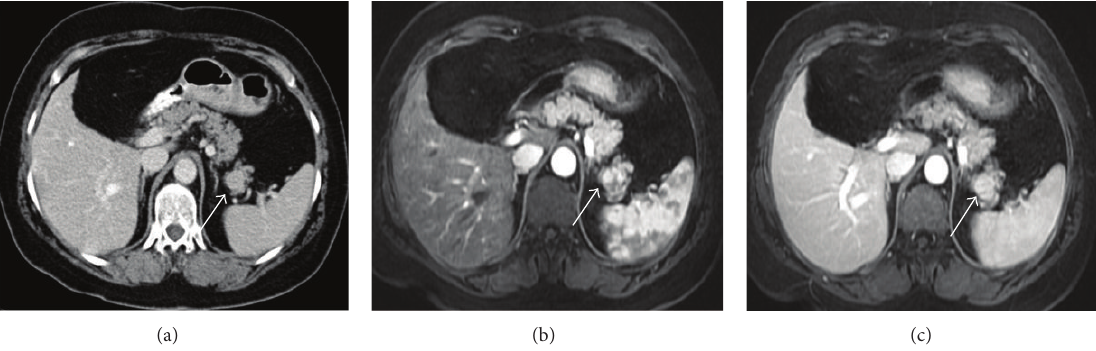
Figure 4: Axial contrast enhanced CT image (a), contrast enhanced T1-weighted image at arterial (b) and venous phases (c) show an intrapancreatic nodular mass in a 63-year-old female patient. The mass has similar density at CT and contrast enhancement pattern at MR images with the spleen indicating an intrapancreatic accessory spleen.